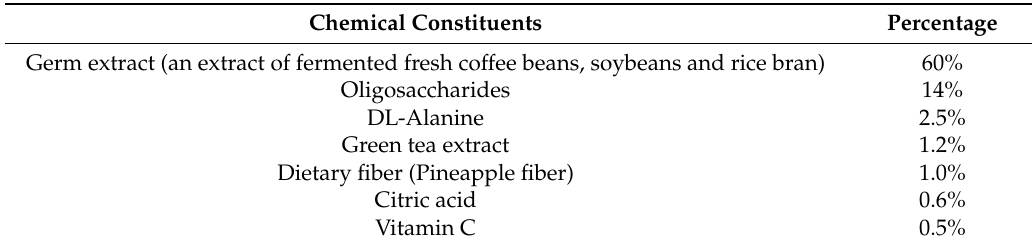
Table 1. Chemical composition of SOD-Like